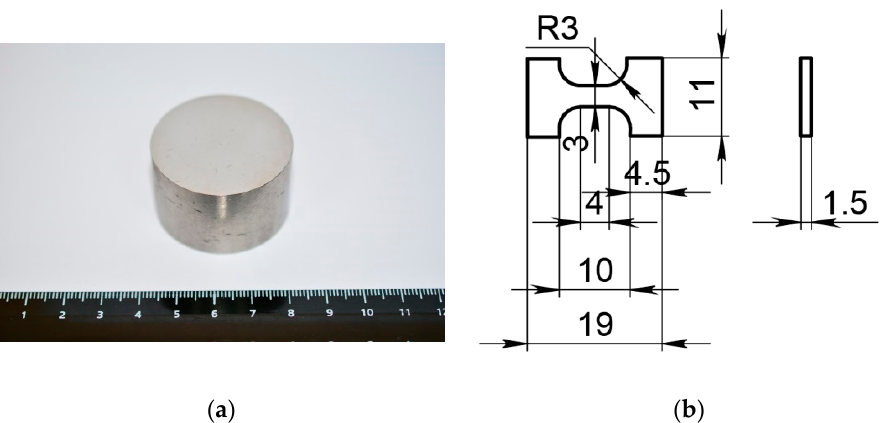
Figure 2. ( a ) Sintered Ti-15Mo/TiB composite and ( b ) scheme of the tensile specimen (dimensions in mm).